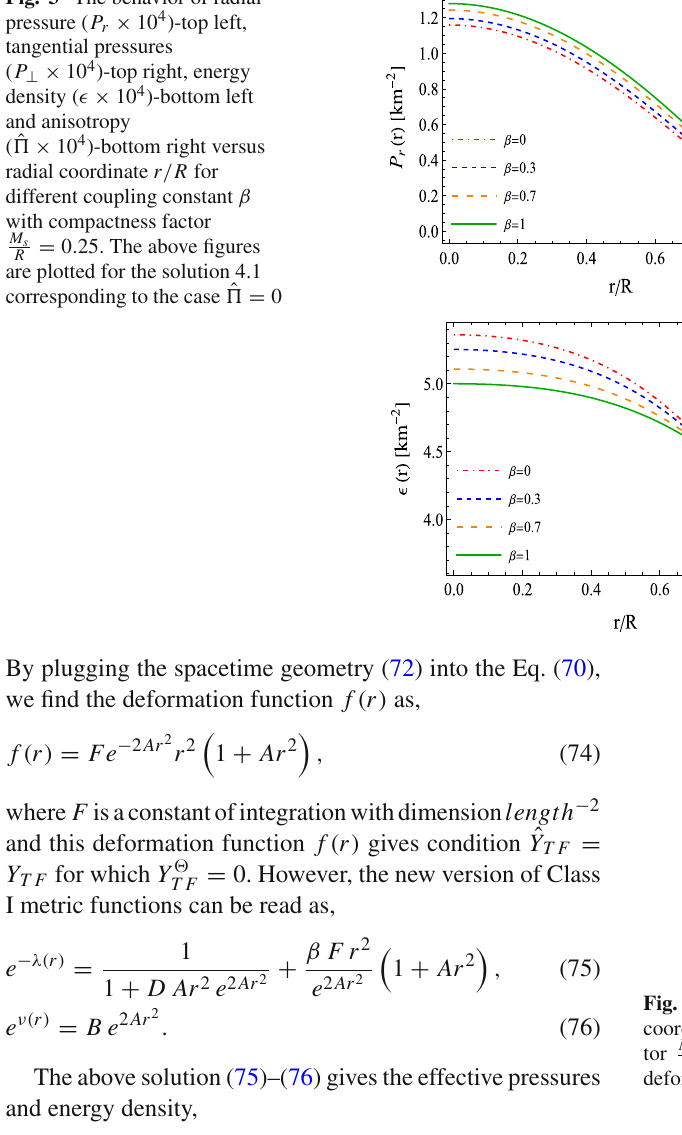
Fig. 3 The behavior of radial pressure ( P r × 10 4 )-top left, tangential pressures ( P ⊥ × 10 4 )-top right, energy density ( (cid:13) × 10 4 )-bottom left and anisotropy ( ˆ (cid:14) × 10 4 )-bottom right versus radial coordinate r / R for different coupling constant β with compactness factor M s = 0 . 25. The above figures R are plotted for the solution 4.1 corresponding to the case ˆ (cid:14) = 0